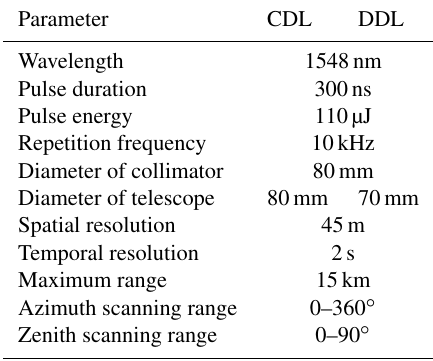
Table 1. Key parameters of the integrated